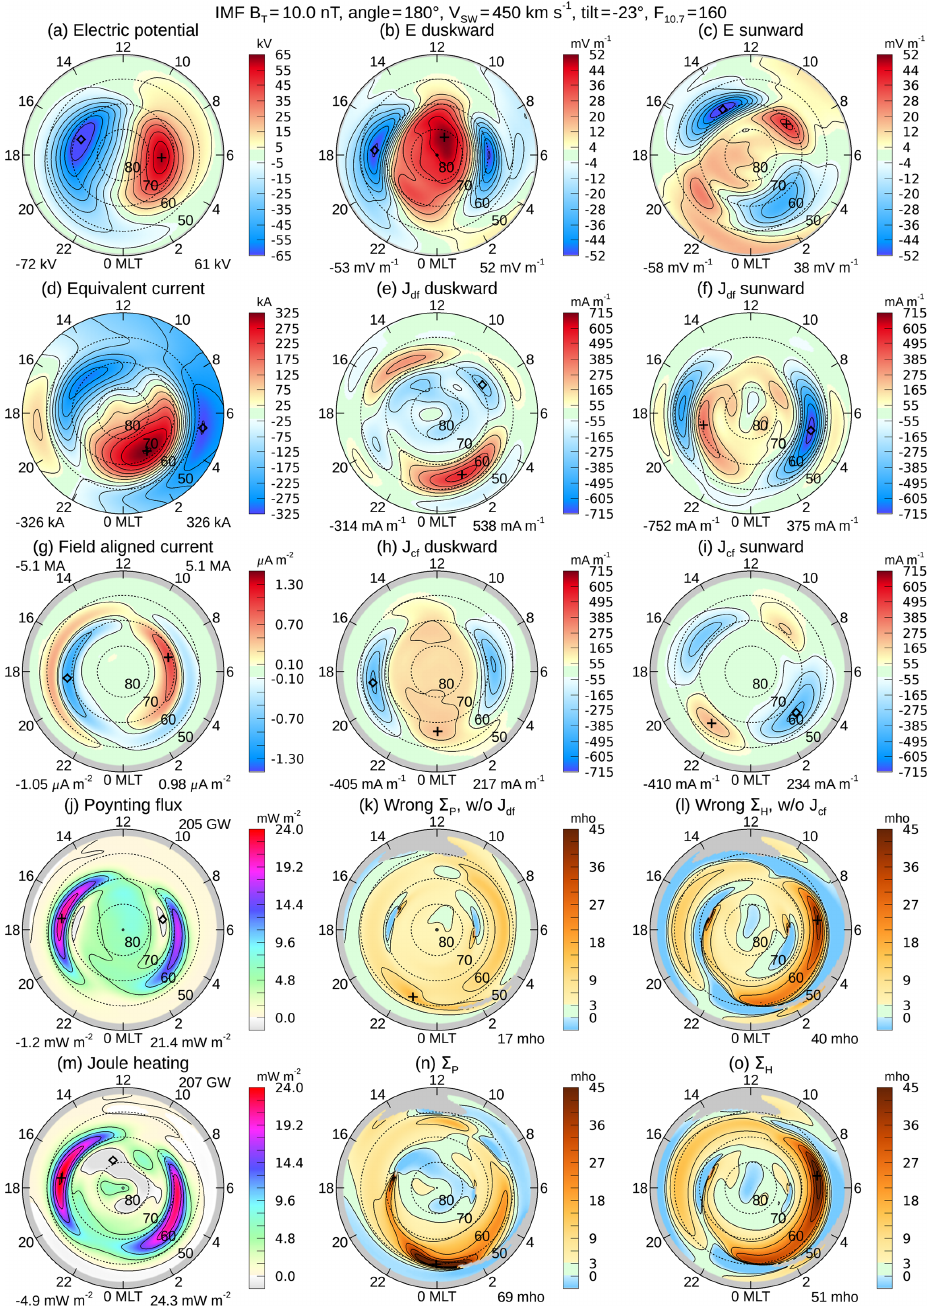
Figure 2. Conductivity input data and results for the same conditions as in Fig. 1, except that the dipole tilt angle is for winter conditions. The IMF B T magnitude is 10nT at 180 ◦ , the solar wind velocity is 450km s − 1 , the F 10 . 7 index is 160sfu, and the dipole tilt angle is − 23 ◦ .